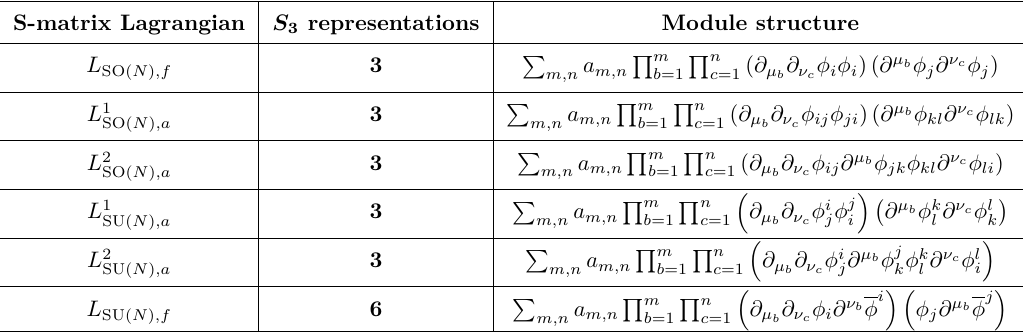
Table 3 . Generators of scalar local module with global